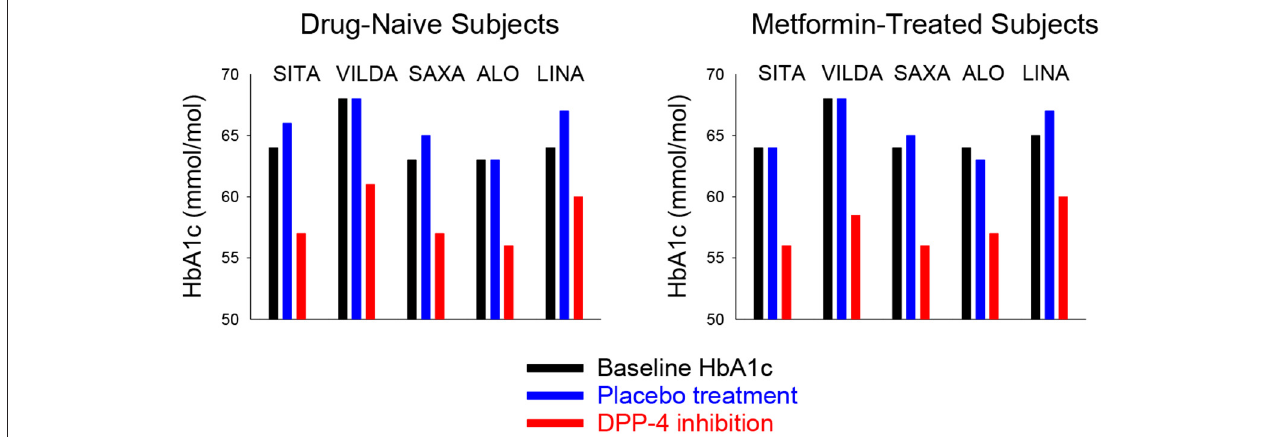
FIGURE 7 | Mean baseline HbA1c and mean HbA1c after 24–26 weeks of treatment with placebo or a DPP-4 inhibitor in drug-naïve ( Left ) or metformin-treated ( Right ) subjects with type 2 diabetes in studies reported in Table 2 . SITA, sitagliptin; VILDA, villdaglipin; SAXA, saxagliptin; ALO, alogliptin; LINA, linagliptin.